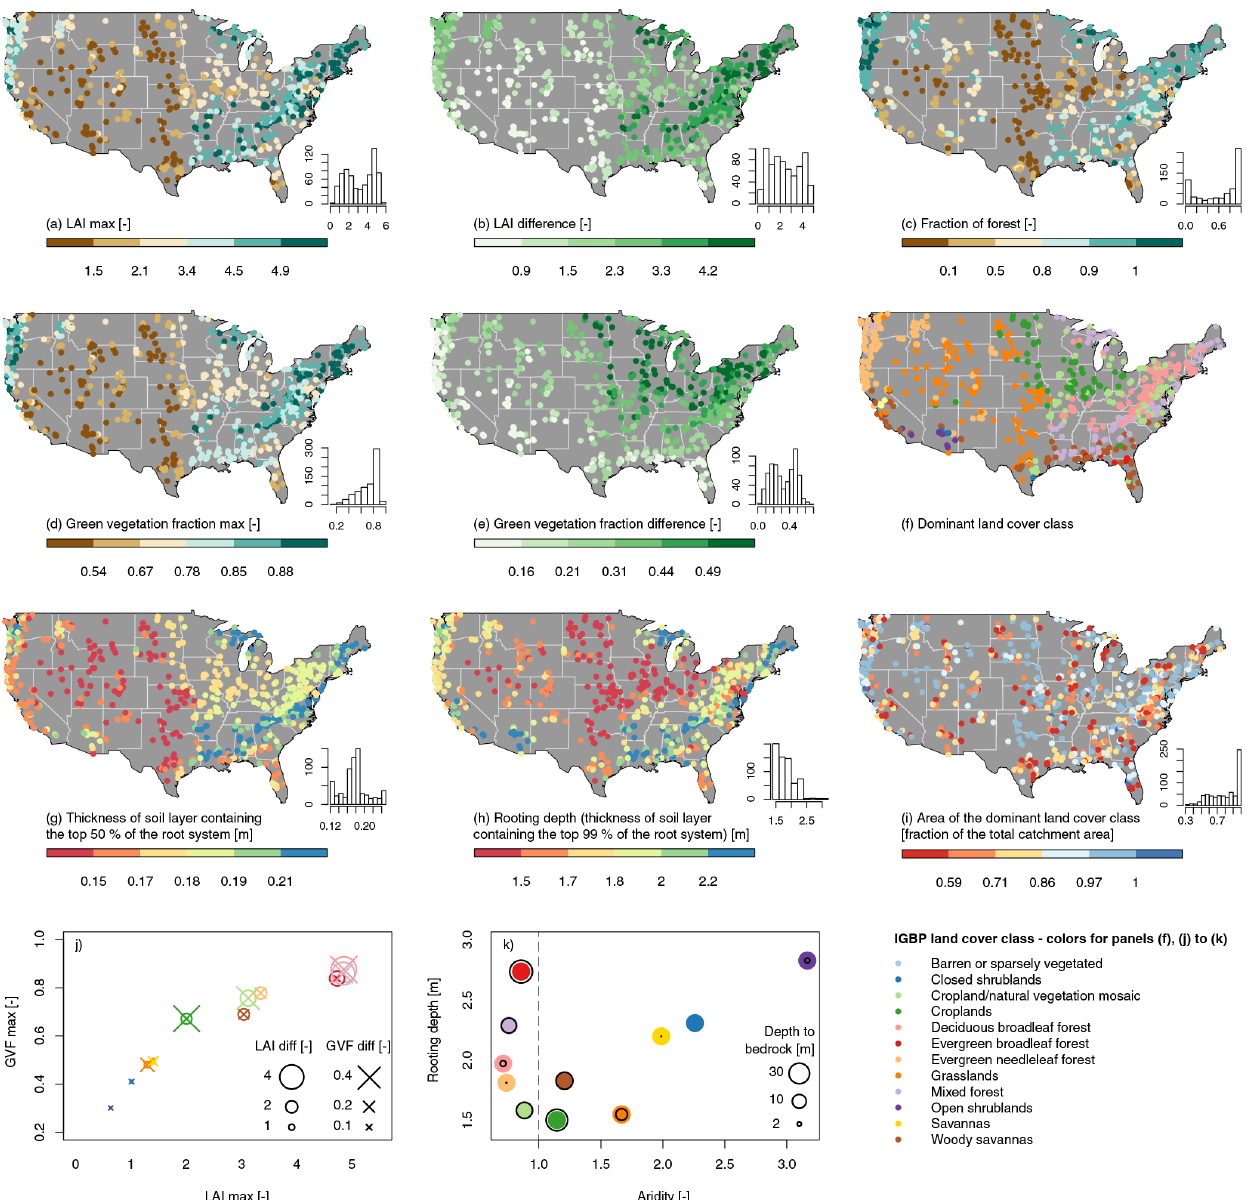
Figure 5. (a–i) Maps of vegetation characteristics over the CONUS. The histograms indicate the number of catchments (out of 671) in each bin. (j) Comparison of the LAI and GVF (maximum and difference between maximum and minimum) based on the dominant land cover class. (k) Comparison of the mean aridity, mean total rooting depth, and mean depth to bedrock for each land cover class; the colored dots all have the same